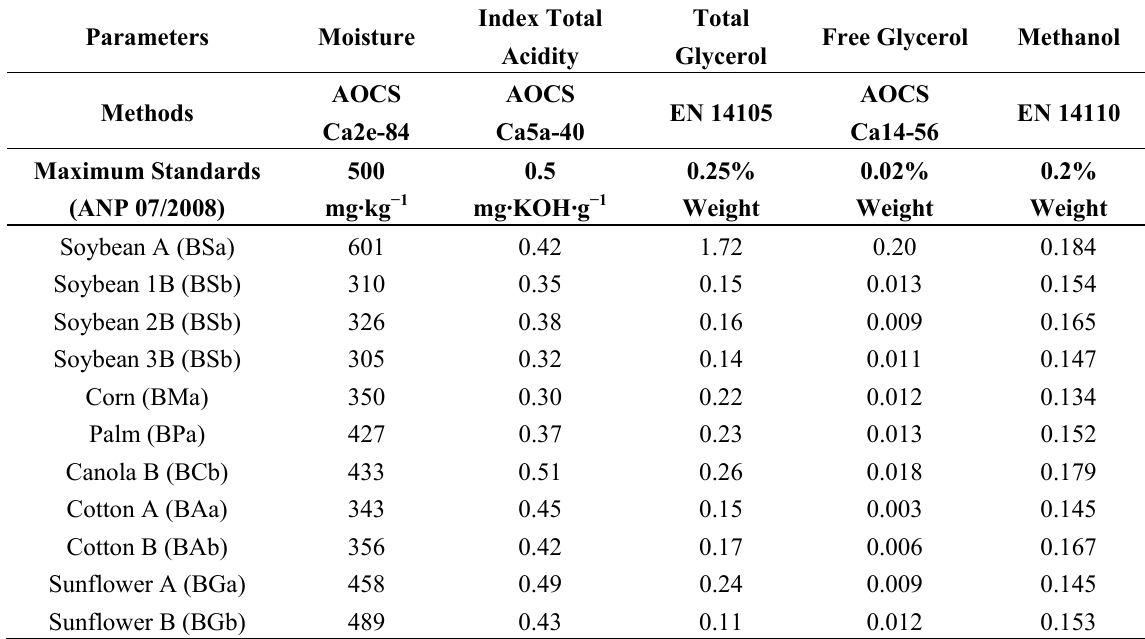
Table 2. Results of standardized methods for the characterization of samples of